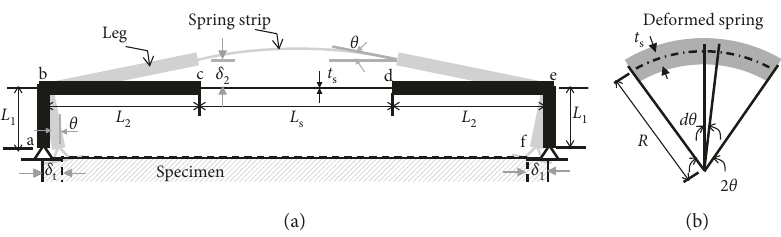
Figure 2: (a) Schematic showing various components of the axial spring deformation gauge. (b) Curvature of the spring for elongation calculation.